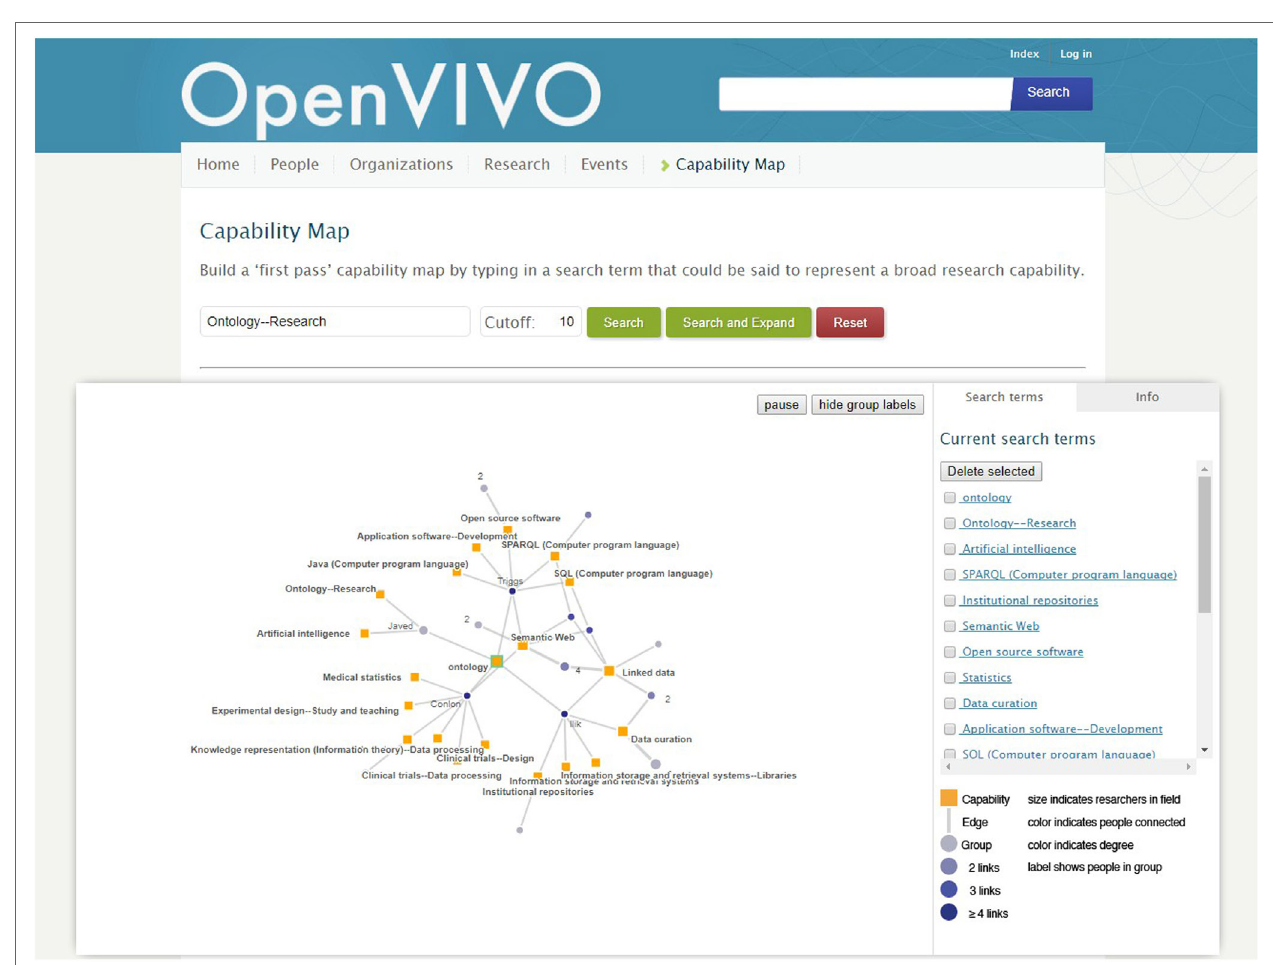
FIguRe 3 | The capability map allows users to select concepts of interest, displaying people whose work involves those concepts. Connections between people represent coauthorship. The map can be tuned, navigated, and “drilled down” to individual